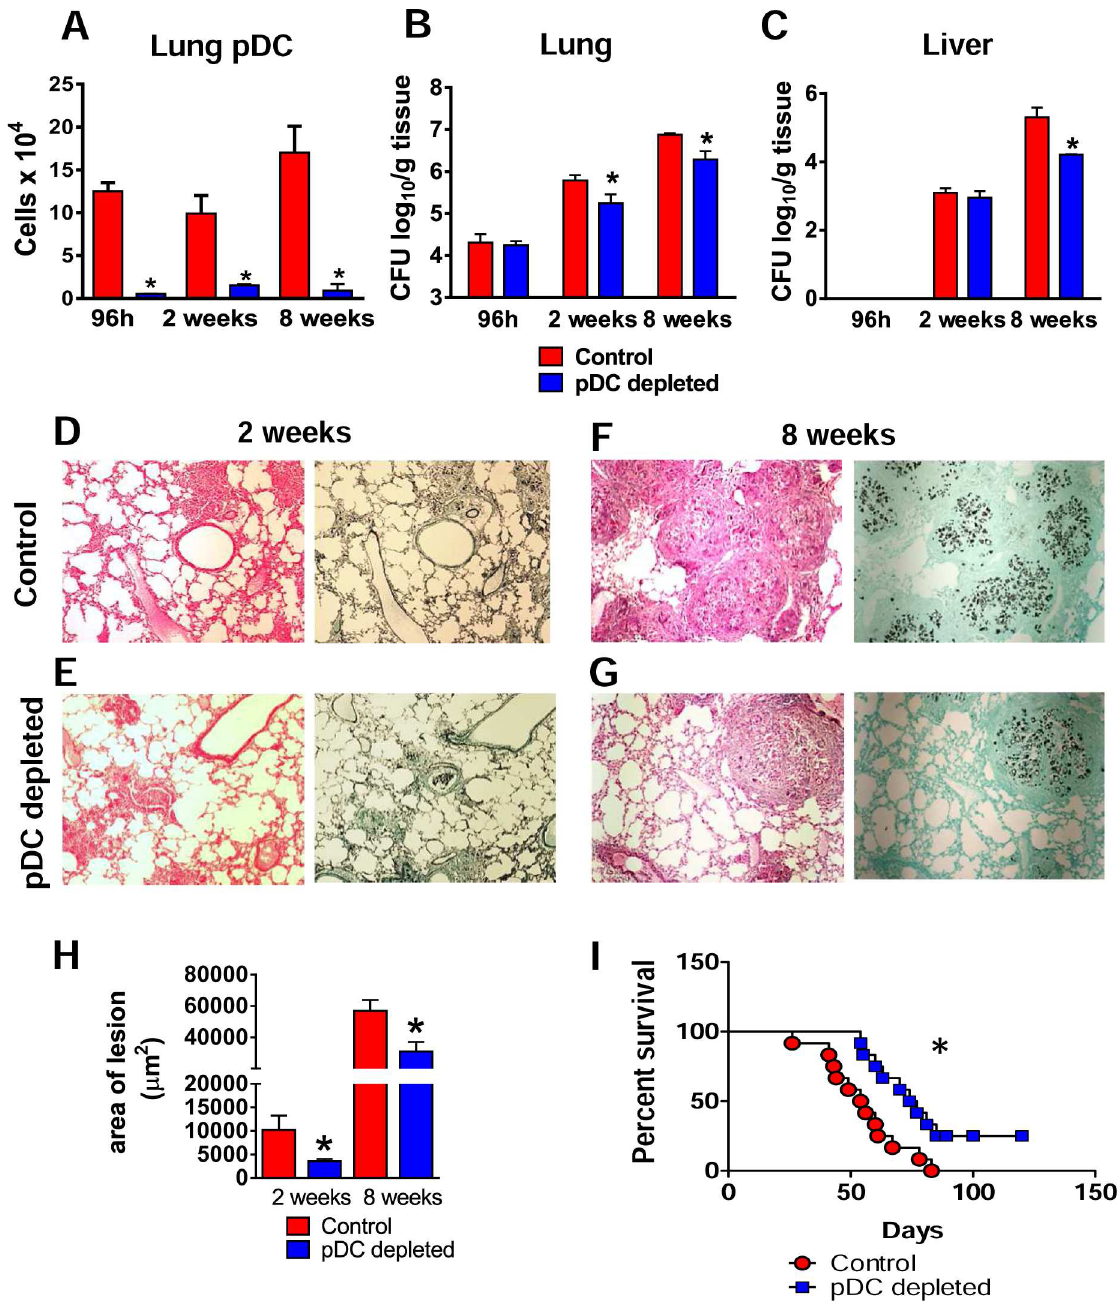
Fig 2. Depletion of pDCs reduces fungal loads, tissue injury and mortality rates. Groups of anti-CD317(anti-PDCA; clone BX44) or control rat IgG (clone HRPN) treated mice were infected i.t. with 1 × 10 6 yeasts cells of P . brasiliensis . At 96 h, 2 and 8 weeks post-infection lungs were removed, leukocytes obtained and the numbers of pDC analyzedby flow cytometry (A). Colony- forming unit (CFU) counts from lungs (B) and liver (C) were determined 96 h, 2 and 8 weeks after P . brasiliensis infection. The bars represent means ± standarderrors of the mean (SEM) of log 10 CFU counts obtainedfrom groups of 4–5 mice. (D–G) Photomicrographsof lung lesions of control (D and F) and pDC-depleted mice (E and G) at weeks 2 (D And E) and 8 (F and G) of infection. Lesionswere stained with hematoxylin-eosin (left panels) and Grocott (right panels). (See also S1 Fig for liver lesions). (H) Total area of lesionsin the lungs at week 2 and 8 of infection. (I) Survivalcurves of pDC-depleted and control infected mice were determinedin a periodof 110 days. Data represent the means ± SEM of at least 4 mice/group and are representative of two independent experiments with equivalentresults ( * p < 0.05).